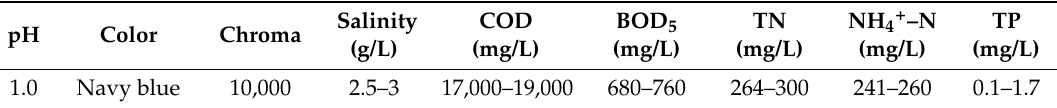
Table 1. Compositions of dying